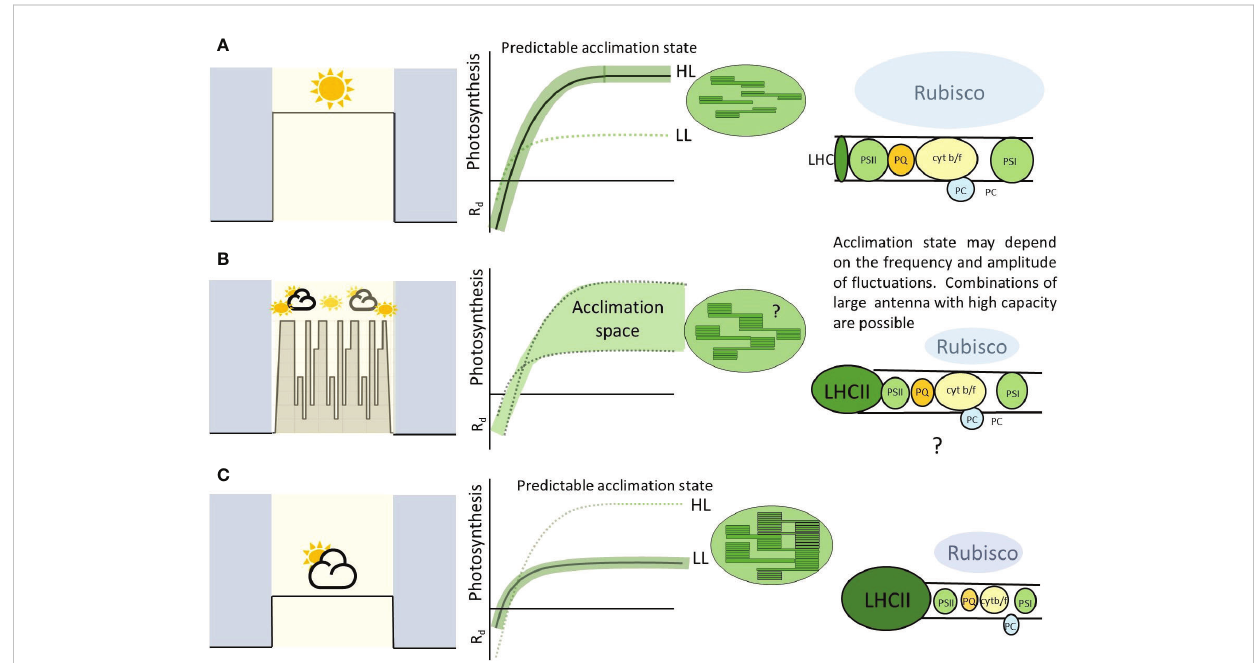
FIGURE 6 A highly schematic fi gure to summarize the principles arising from this paper. ‘ Square wave ’ type growth conditions at a fi xed irradiance result in a predictable acclimation condition (A, C) . This allows especially high ef fi ciency at these given light levels. Fluctuating conditions, whether natural or imposed, can result in combinations of responses and stoichiometries of the various chloroplast components (B) . This is likely to be dependent on the plant, genotype and properties of the imposed light. The cartoon electron transport chain (right pannels) shows the amount of each component proportional with balloon size. In this paper we highlight the possibility of large antenna but high photosynthetic capacity perhaps conferred by higher amounts of electron transport components. This allows the leaf to provide a wider ‘ acclimation space ’ and exploit high and low light with higher ef fi ciency than (A) or (C)